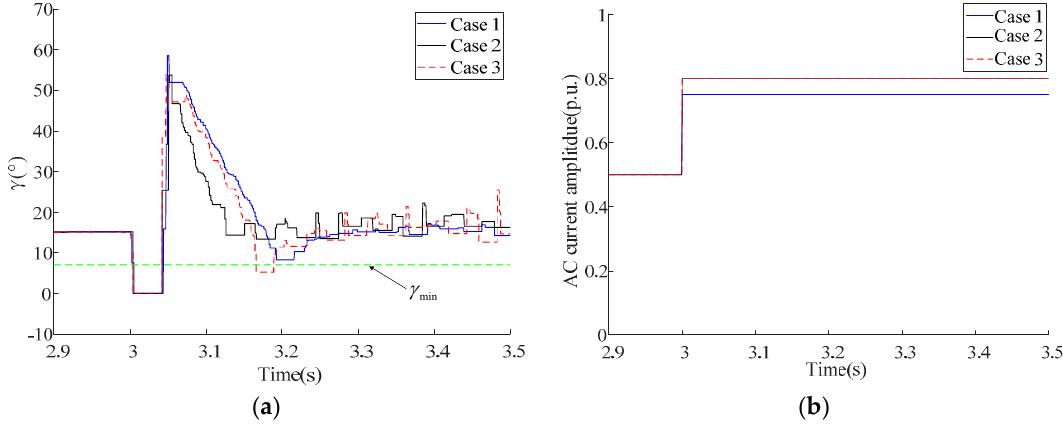
Figure 9. System performance under different power operation points. ( a ) Extinction angle of the LCC ‐ HVDC inverter; ( b ) AC current amplitude of the VSC inverter side.